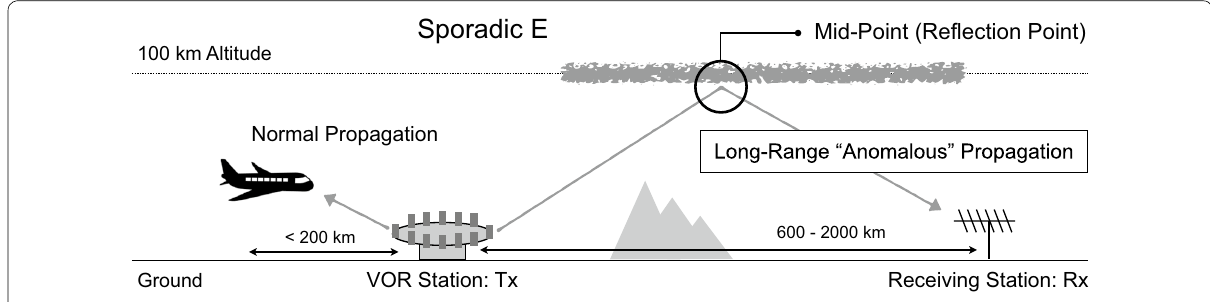
Fig. 1 A sketch anomalous long-distance propagation of VHF radio waves for aeronautical navigation system due to sporadic